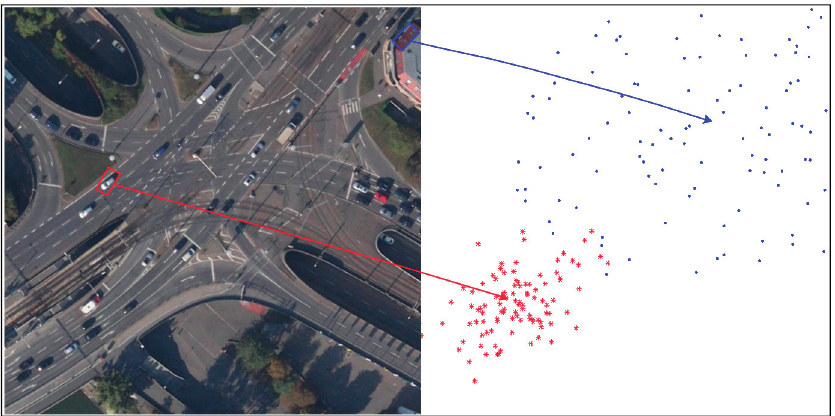
Figure 3. The distribution of motion vectors in